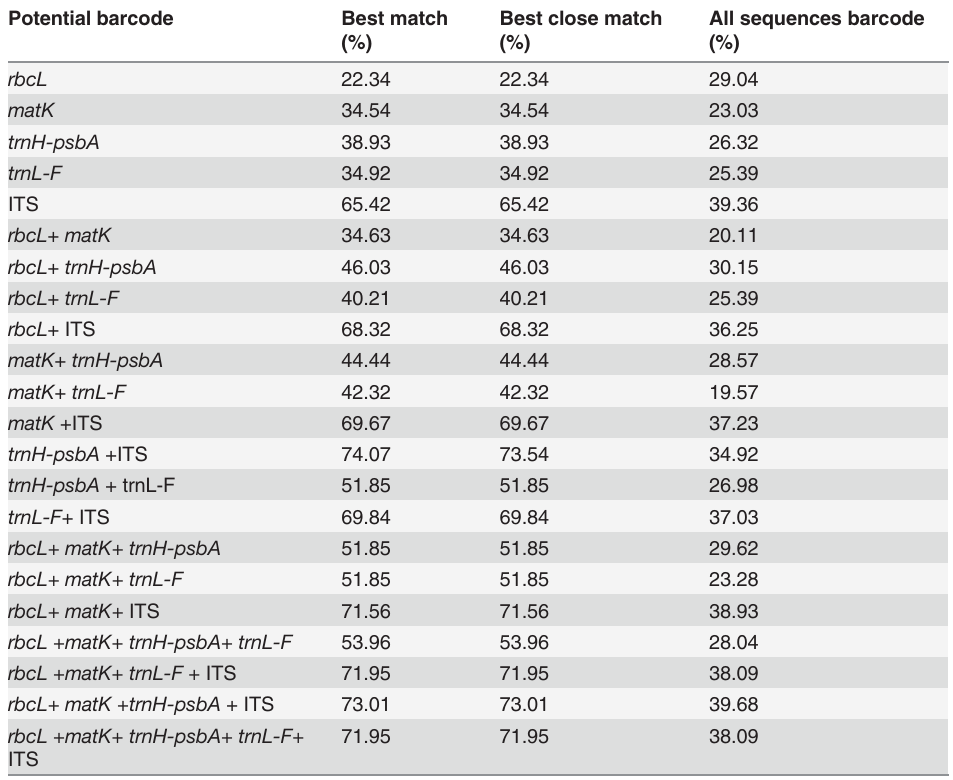
Table 5. Success rates of species identi fi cation based on TaxonDNA